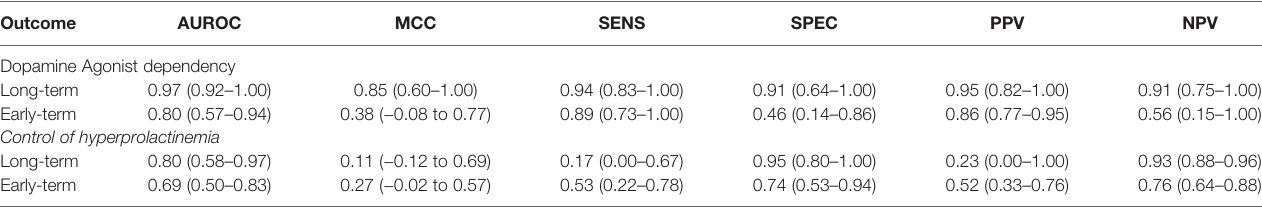
TABLE 3 | Performance metrics of a stacked super learner combining the outcome predictions of the individual classi fi ers (referred to as base learners ; see method section). Outcome AUROC MCC Dopamine Agonist dependency